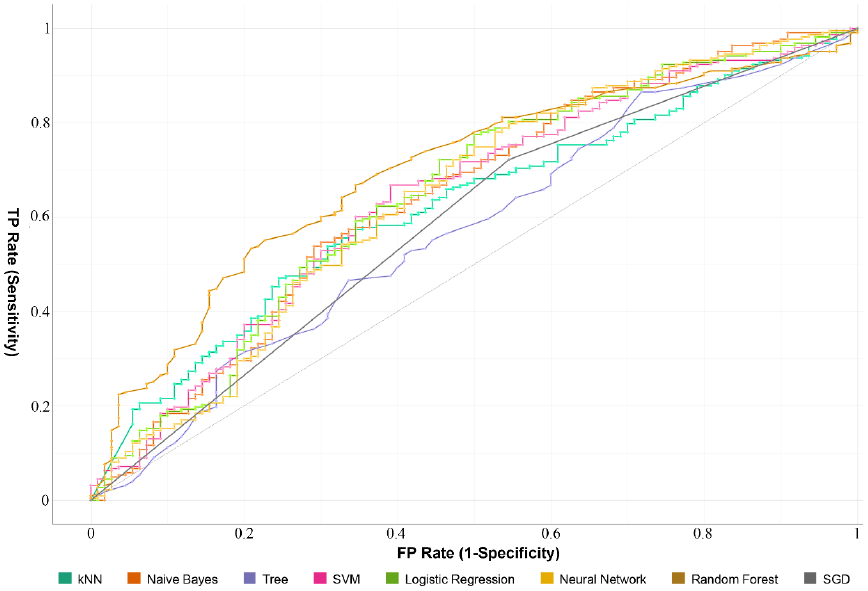
Figure 5. ROC curves showed the predictive efficiency of the prognostic model of TCGA dataset. 170 Table 1. Evaluation results of models based on different algorithms. 171